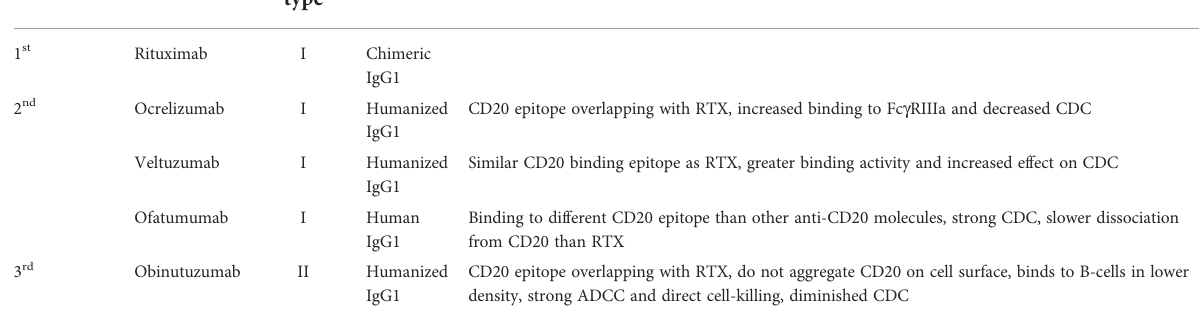
TABLE 1 Characteristics of anti-CD20 monoclonal